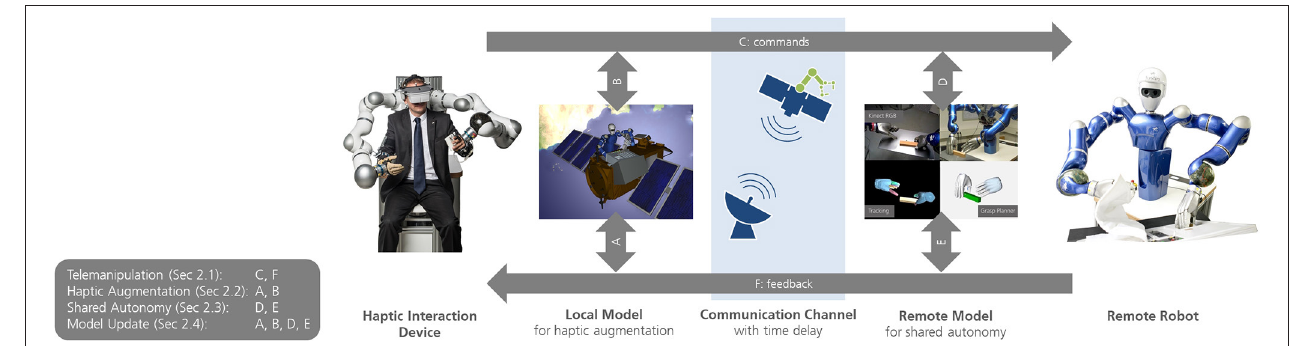
FIGURE 3 | Illustration of the control scheme of MATM. The local and the remote model can both read and modify (or augment) the commands to the remote robot and the feedback to the operator. Certain methods and situations demand such full signal access, as explained in the respective subsections.